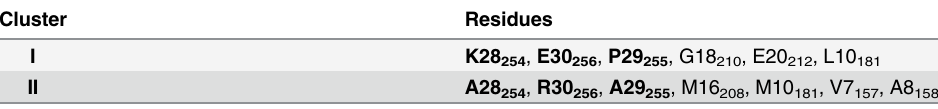
Listed in decreasing order of partial MI value. Residues in bold correspond to known SDPs. Subscripted positions correspond to those in PDB structure 1U46:A.